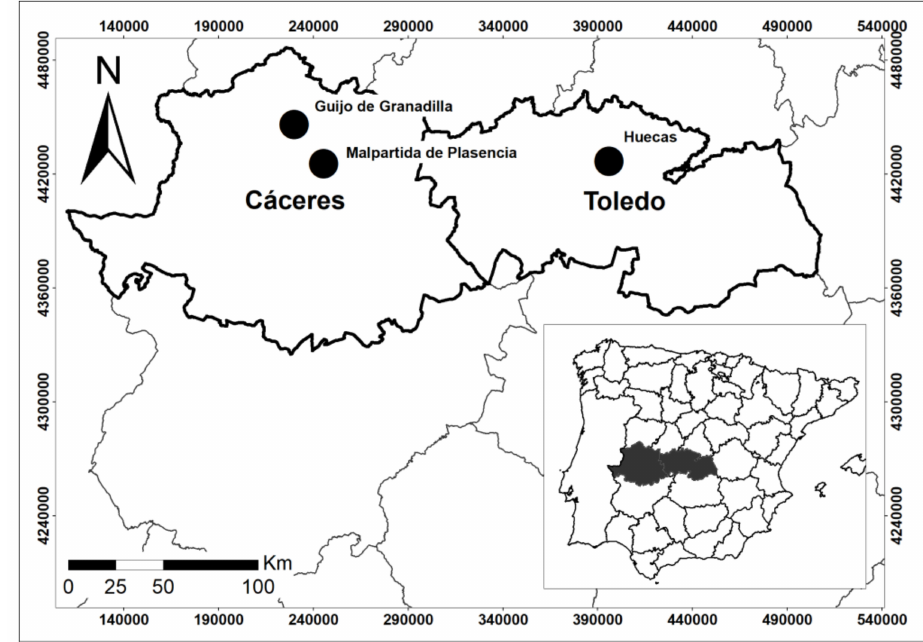
Figure 1. Location of the three study sites in the Iberian